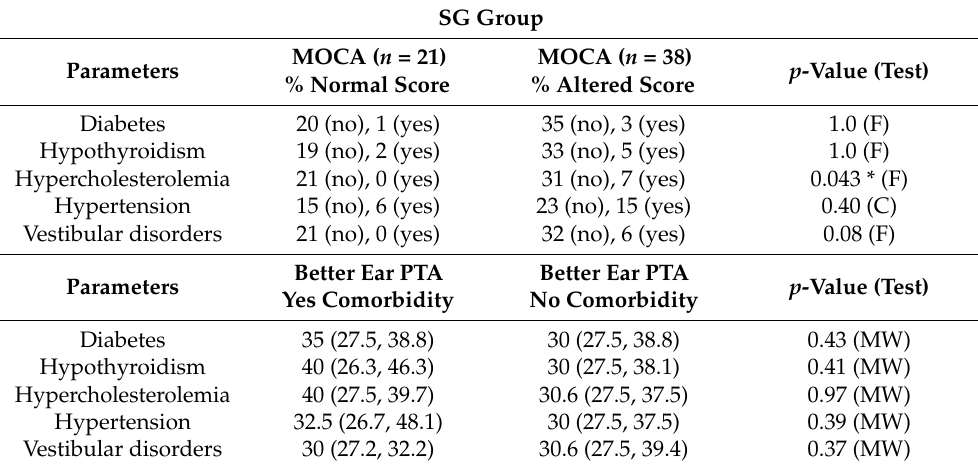
Table 6. Relationship analysis between the better ear PTA and MoCA parameter with comorbidities for the study